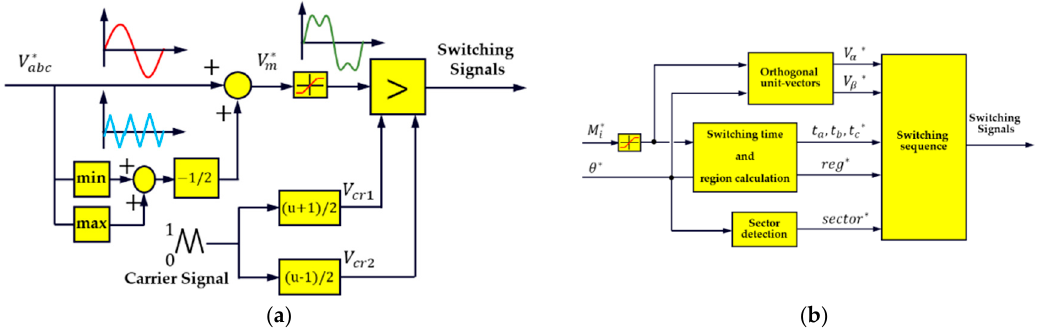
Figure 15. Asynchronous modulation techniques: ( a ) Pulse-Width Modulation (PWM) with triple harmonic injection; ( b ) Space-Vector Modulation (SVM).